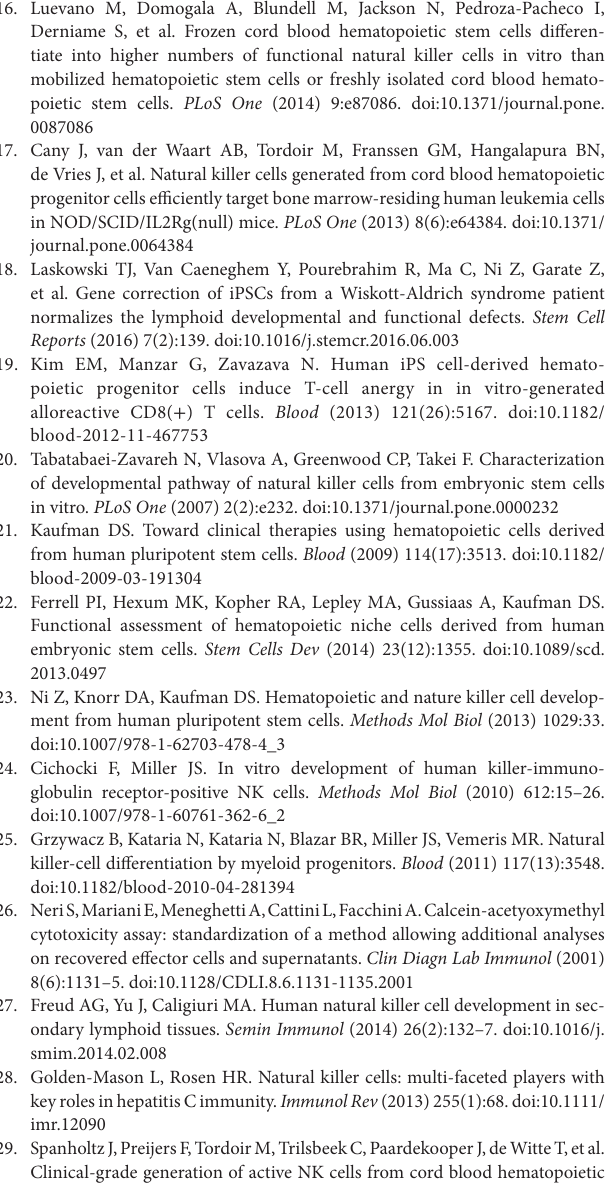
TaBle s1 | Number of fresh umbilical cord blood (UCB) units, volume in milliliters, number of mononuclear cells per UCB, and CD34 + cells remaining after purification for each experiment. UCB were fresh, being not longer than 30 h after the extraction. FigUre s1 | (a) Purity of CD34 + cell population from umbilical cord blood (UCB) obtained by immunomagnetic isolation. (B) Remaining percentage of CD56 + cells after purification of CD34 + cells from UCB. FigUre s2 | Total number of CD56 + cells at different time points during the in vitro differentiation protocol with three different culture conditions: OP9 and M2-10B4 cells coculture (N:4) and feeder-free (N:2). FigUre s3 | Key markers expressed at different stages through natural killer cell differentiation/maturation in vivo and in vitro . FigUre s4 | Dot-plots of the expression of CD3 at different stages of natural killer cells during the differentiation